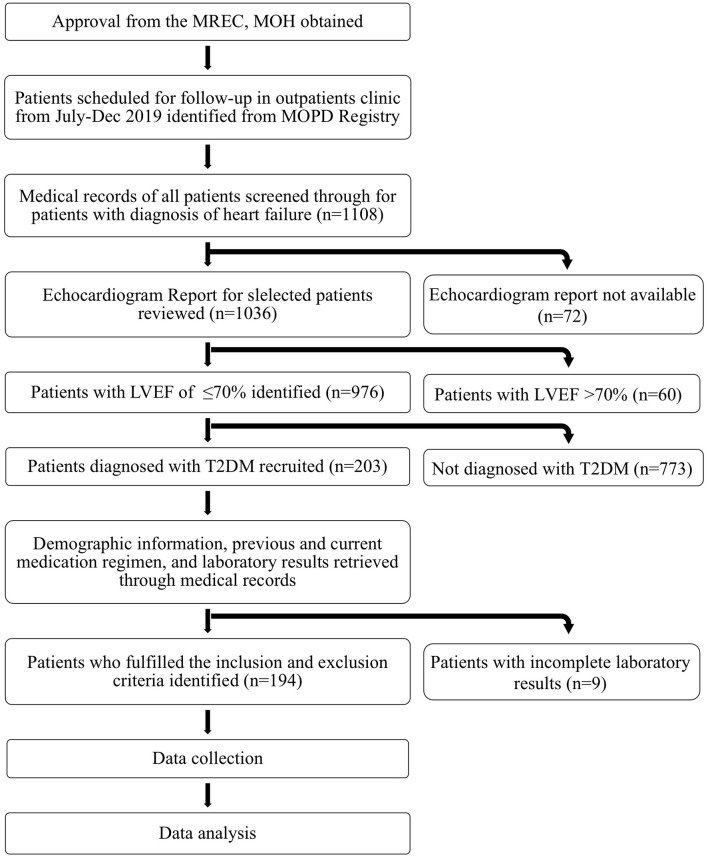
Overview of study design and study subjects' selection.